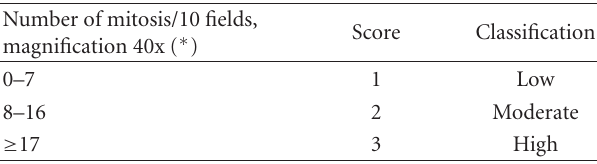
Table 1: Correlation between the mitosis number and mitotic index in